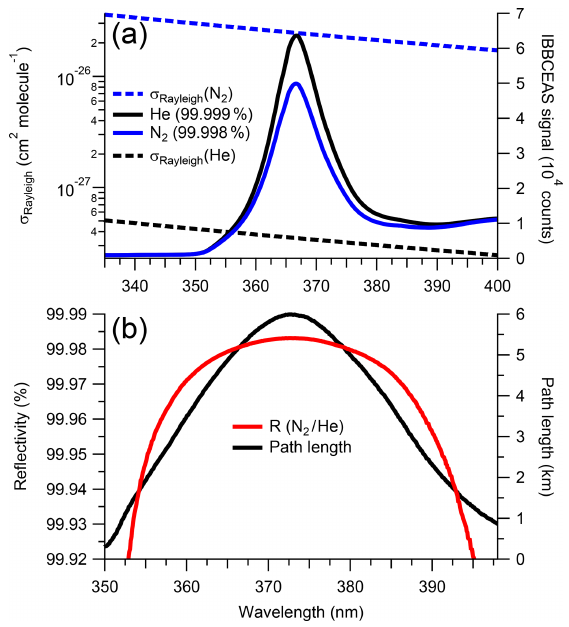
Figure 2. (a) Cavity output signal for samples of N 2 (99.998%) and He (99.999%), and their scattering cross sections by Peck and Khanna (1966) and Cuthbertson and Cuthbertson (1932), respec- tively. The cavity output signal is a function of the LED spectral output and the superimposed mirror reflectivity and filter functions. (b) Reflectivity curve calculated from the ratio of He to N 2 (shown above) using Eq. (2). The effective path length d/( 1 − R) is shown in